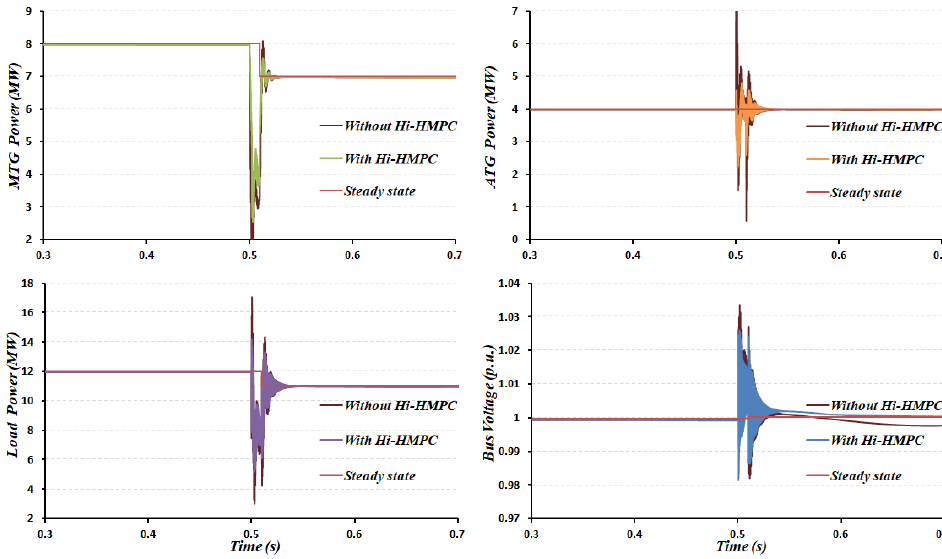
Figure 6. Performance demonstration of Hi-HMPC in real time simulation of scenario 1.